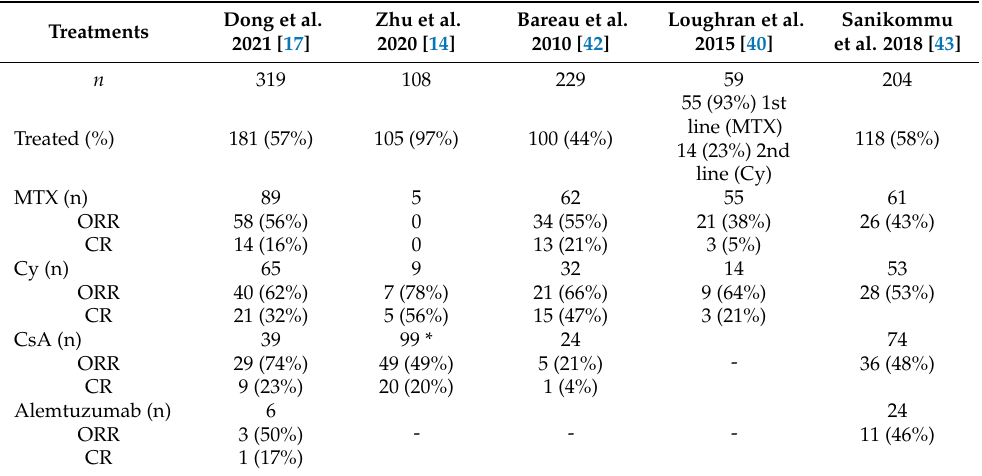
Table 1. Response to different therapies reported in the largest study cohorts of LGLL patients. The data presented are derived from a meta-analysis of the existing